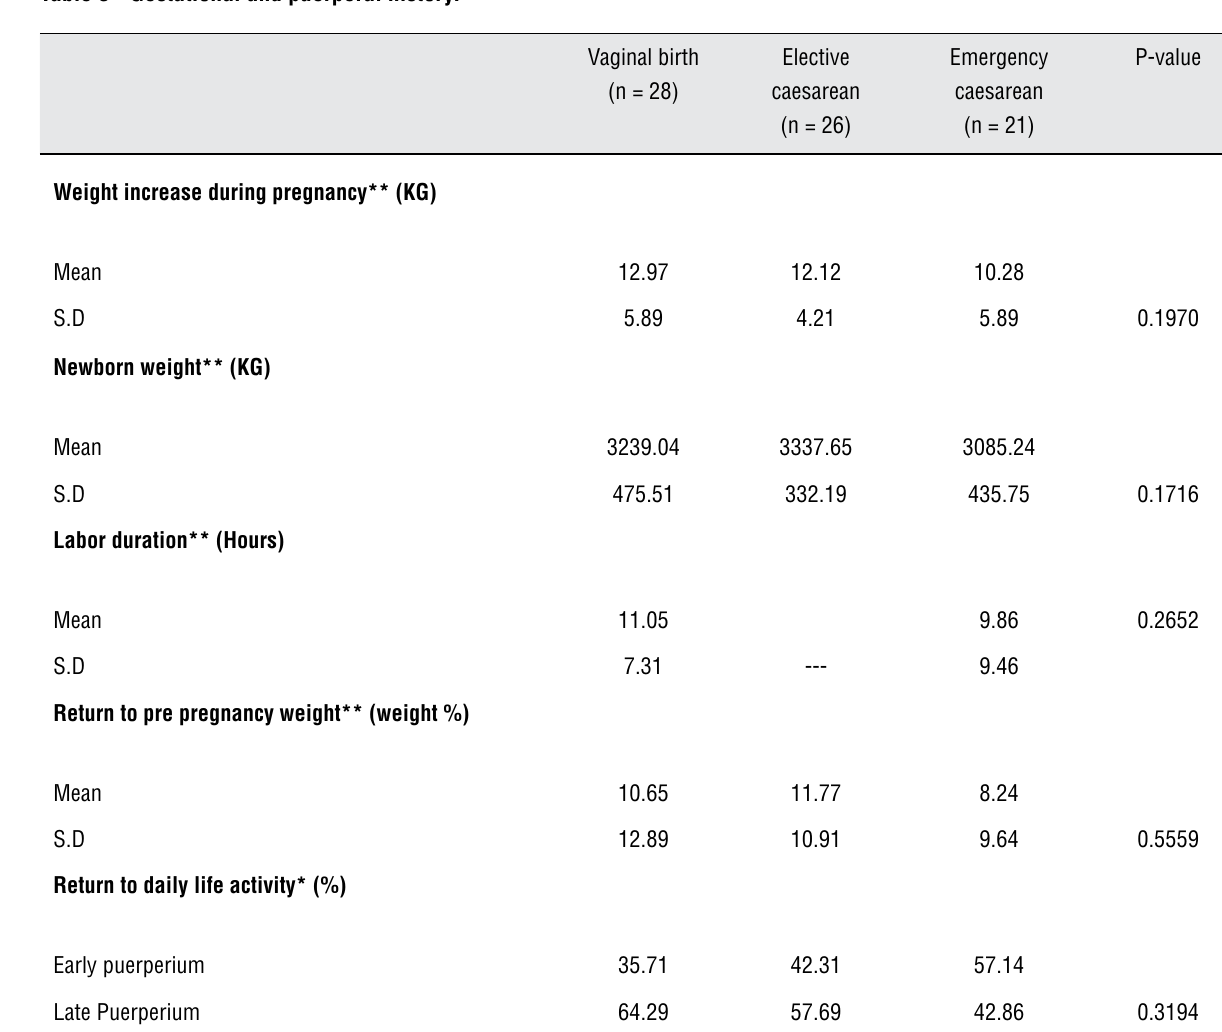
Table 3 - Gestational and puerperal